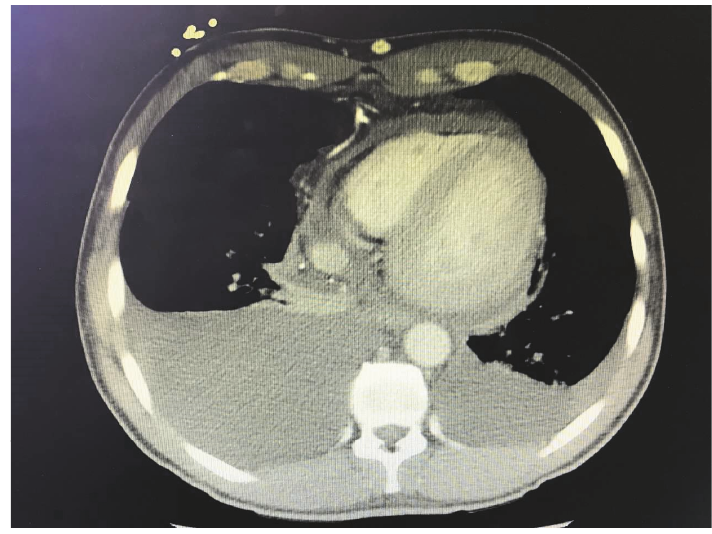
Figure 2: Demonstrates reaccumulation of pleural and pericardial fluid.